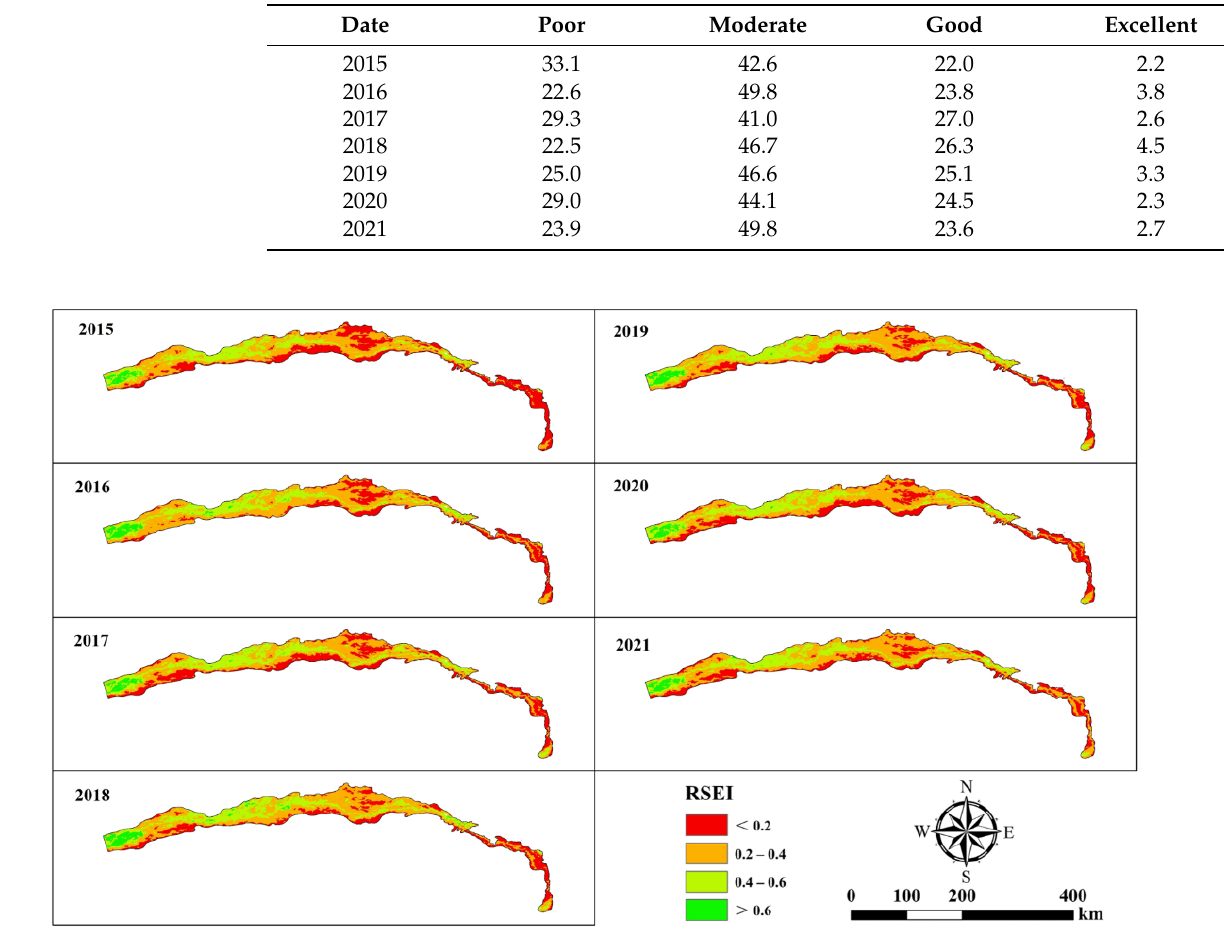
Figure 11. Spatial distribution of RSEI in the mainstream area of the Tarim River. Analyses based on remote sensing ecological index values for the mainstream of Tarim River from 2015 to 2021 showed that the average remote sensing ecological index increased by 6.9% from 0.29 in 2015 to 0.31 in 2021, thereby indicating that the ecological quality of the study area tended to improve. The results showed (Figure 12, Table 5) that most of the region had a medium habitat status, with 42.6% of the area in 2015, which increased to 49.8% in 2021. The area with a poor habitat status decreased from 33.1% in 2015 to 23.9% in 2021, and the minimum was 22.5% in 2018. The area with a good habitat status increased from 22.0% in 2015 to 23.6% in 2021, and the maximum was 27.0% in 2017. Thus, the areas with poor ecological environments were gradually been replaced by medium and good ecological environments. Figure 12 shows that the quality of the ecological environment below Wusiman in the middle reaches of the Tarim River improved to some extent after ecological water conveyance for nearly 7 years, and the overall habitat condition